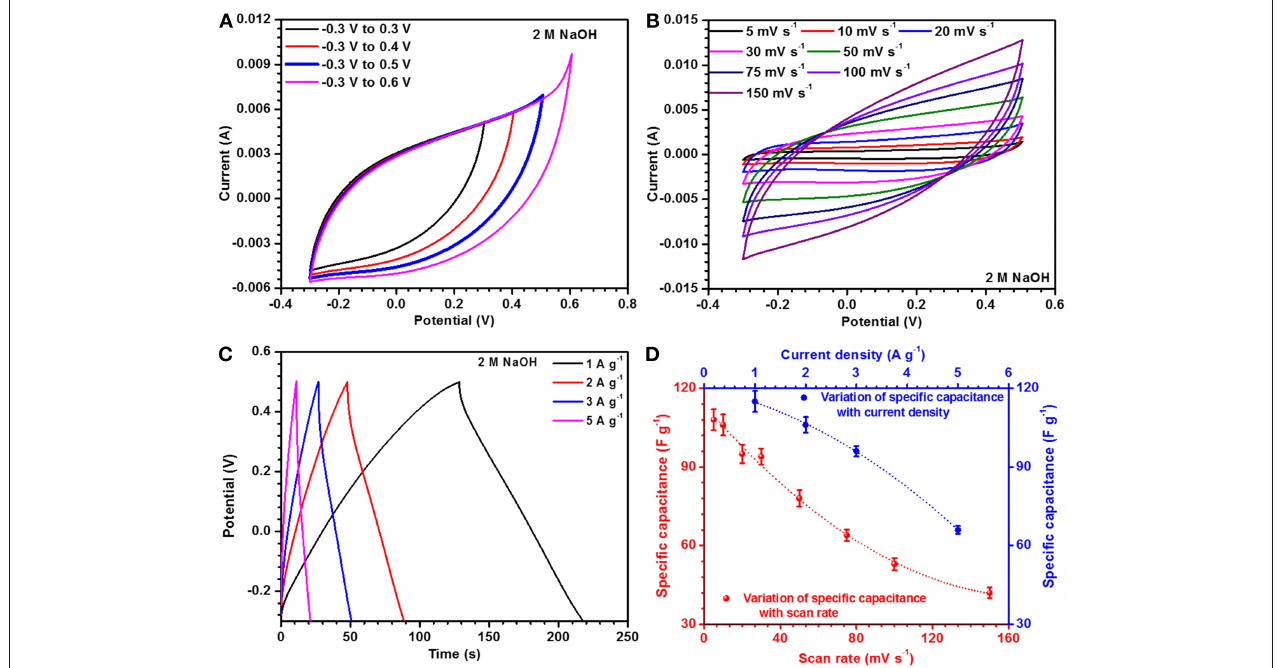
FIGURE 3 | (A) Window optimization, (B) CV profiles, (C) CD profiles, and (D) change in specific capacitance with scan rate and current density of hollow and porous NaFePO 4 in 2M NaOH